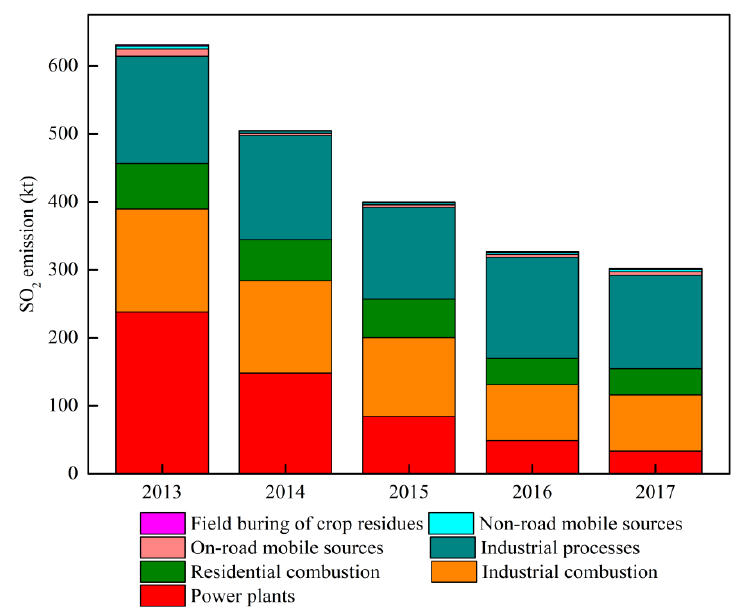
Figure 3. Changes in SO 2 emission in Sichuan during 2013–2017.